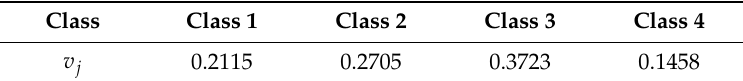
Table 8. The voting rights of each class.